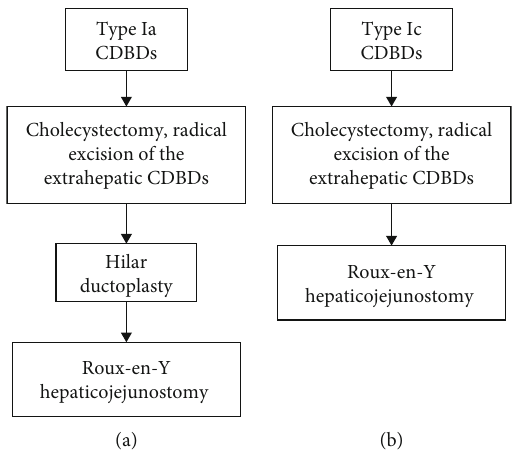
Figure 3: Flow chart of surgical treatment for type Ia (a) and type Ic CDBDs (b).